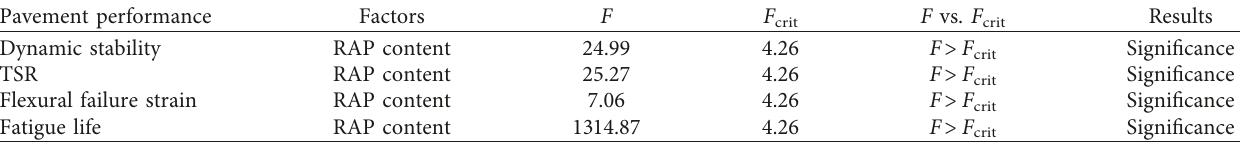
Table 18: Results of ANOVA ( α